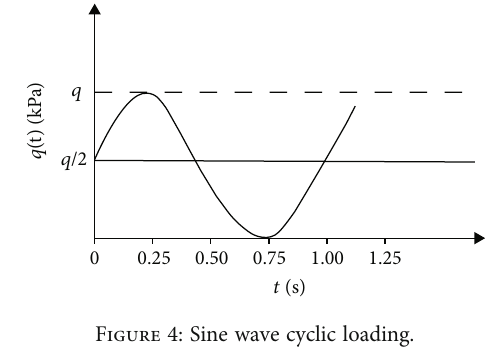
Figure 4: Sine wave cyclic loading.